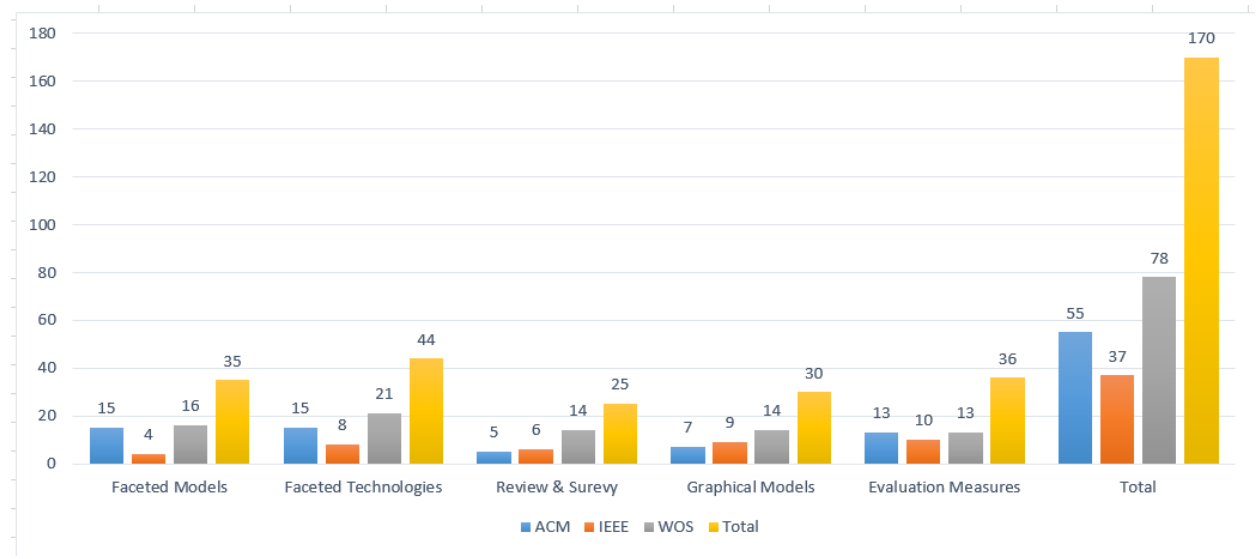
Figure 4. Articles categorized based on their contribution.